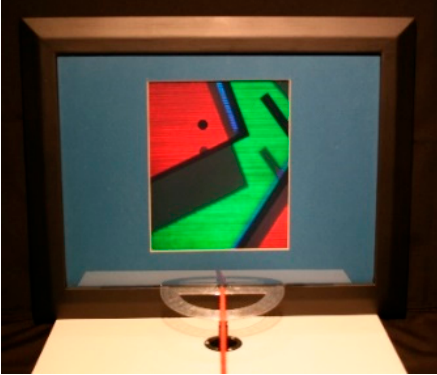
Figure 4. Colour Study with Light Blocks hologram and protractor with string.